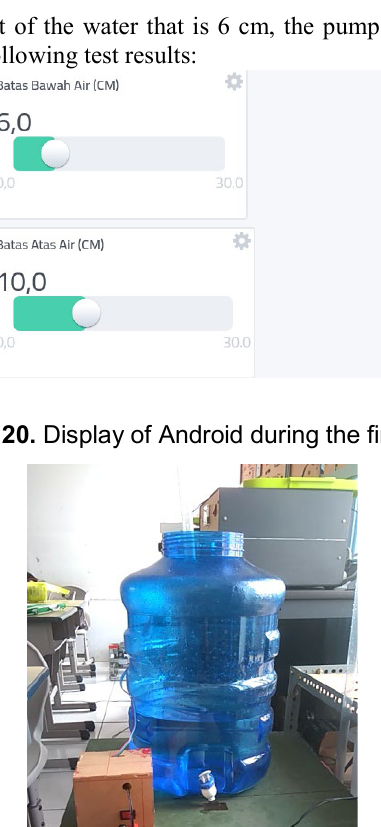
Figure 24. Setpoint Testing upper limit of 15cm